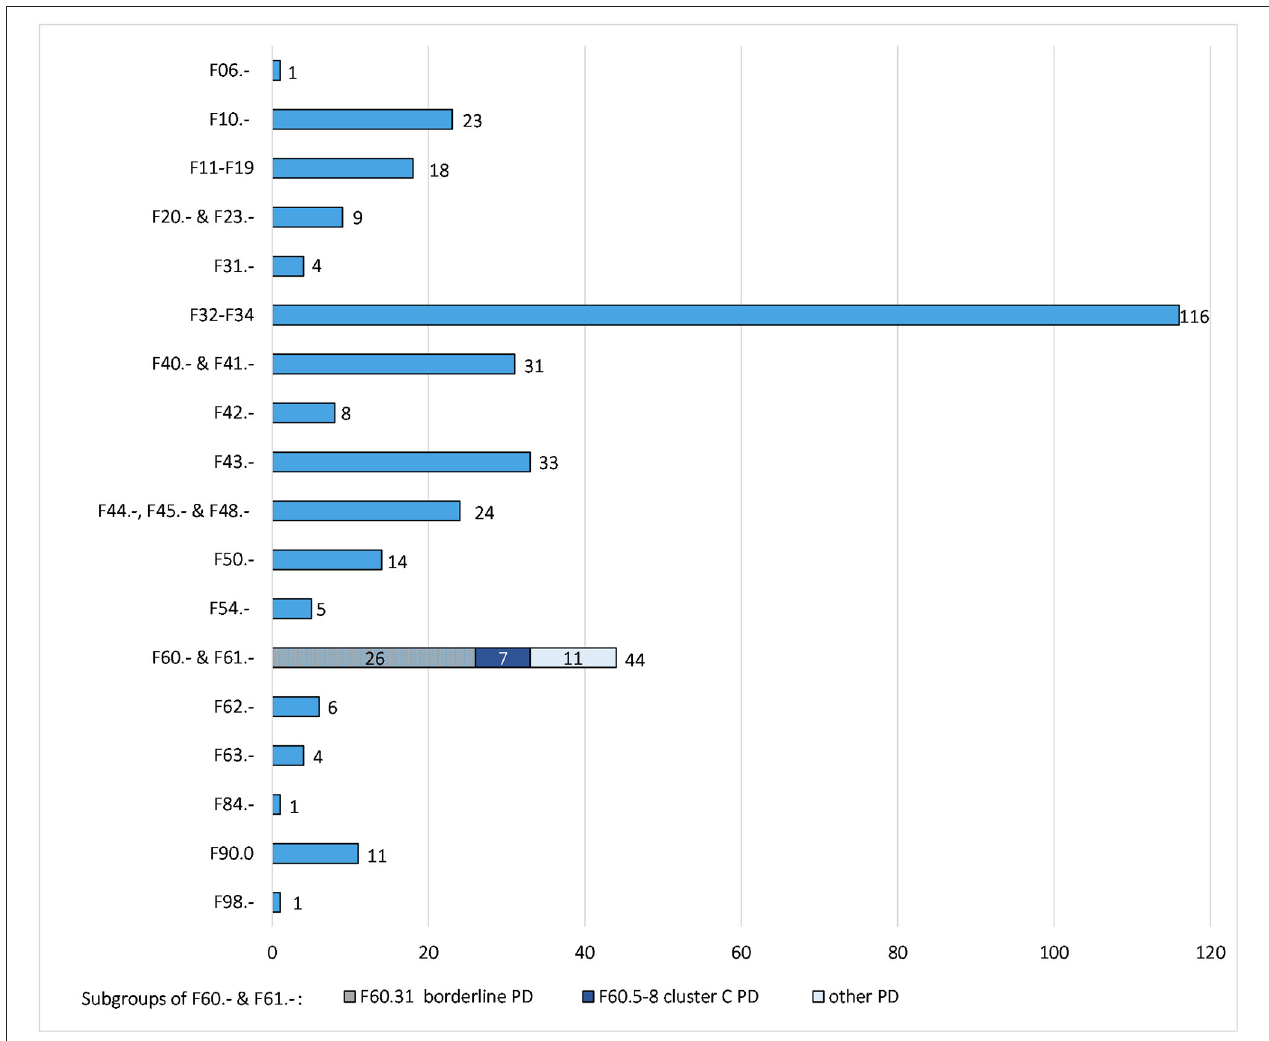
FIGURE 1 | Number of different diagnostic categories in n = 156 patients. F06.- = other mental disorders due to brain damage and dysfunction and to physical disease, F10.- = mental and behavioral disorders due to use of alcohol, F11–F19 = mental and behavioral disorders due to psychoactive substance use besides alcohol, F20.-and F23.- = schizophrenia and other psychotic disorders, F31.- = bipolar affective disorders, F32–F34 = depression, F40.-and F41.- = anxiety disorders, F42.- = obsessive-compulsive disorders, F43.- = reaction to severe stress and adjustment disorders, F44.-, F45.-, and F48.- = dissociative and somatoform disorders, F50.- = eating disorders, F54.- psychological and behavioral factors associated with non-mental disorders, F60.-&F61.- = personality disorders, F62.- = enduring personality changes without brain damage, F63.- = habit and impulse disorders, F84.- = pervasive developmental disorders, F90.0 = attention deficit/hyperactivity disorder, F98.- = other behavioral and emotional disorders with onset usually occurring in childhood and adolescence. PD = personality disorders. The y-axis presents the ICD-10 code of the diagnosis or diagnostic category. The x-axis presents the number of patients with that diagnosis or diagnostic category. Patients with diagnoses belonging to different categories were counted for each category separately. Patients with more than one diagnosis of the same category were counted only once in that category.